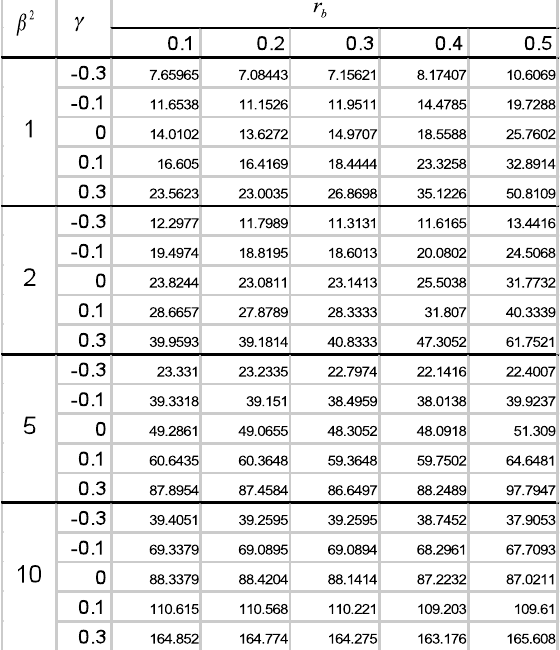
Table 2. Buckling load factor variation with